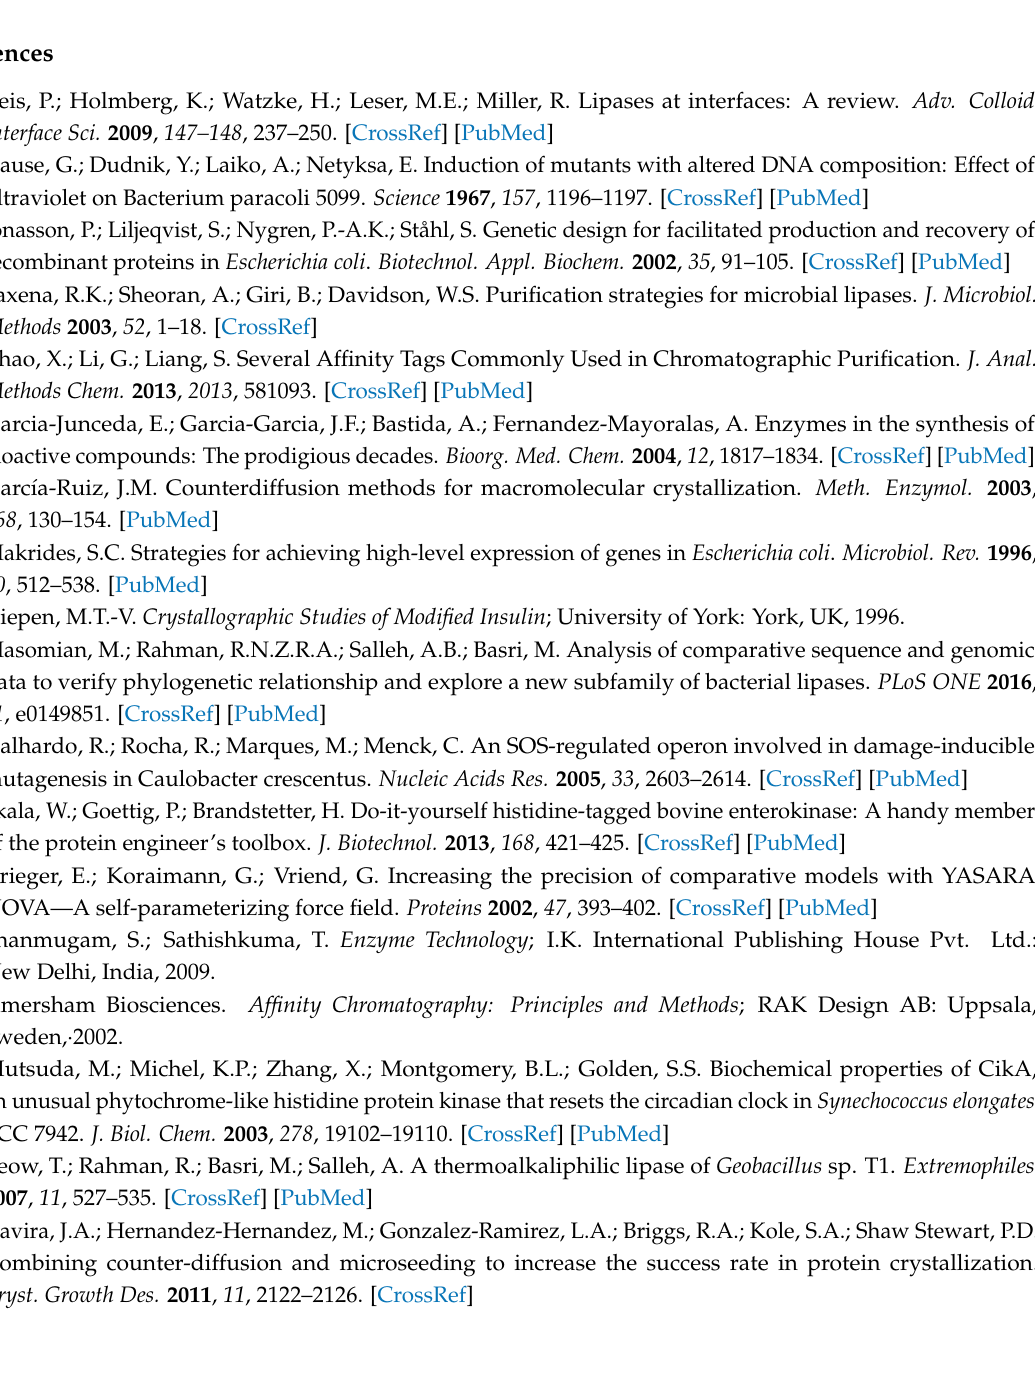
SWISS-MODEL with ERRAT. Table S1. Fatty acid composition (%) of edible fats and oils. Table S2. Biochemical properties of Bacillus and Geobacillus lipases from subfamilies I.4 and I.5. Table S3. PSI blast of HZ lipase gene from A. thermoaerophilus strain HZ with lipases with open conformation. Table S4. Summary of evaluation of two predicted rHZ lipase